Question: Identify the chart type used in this figure.
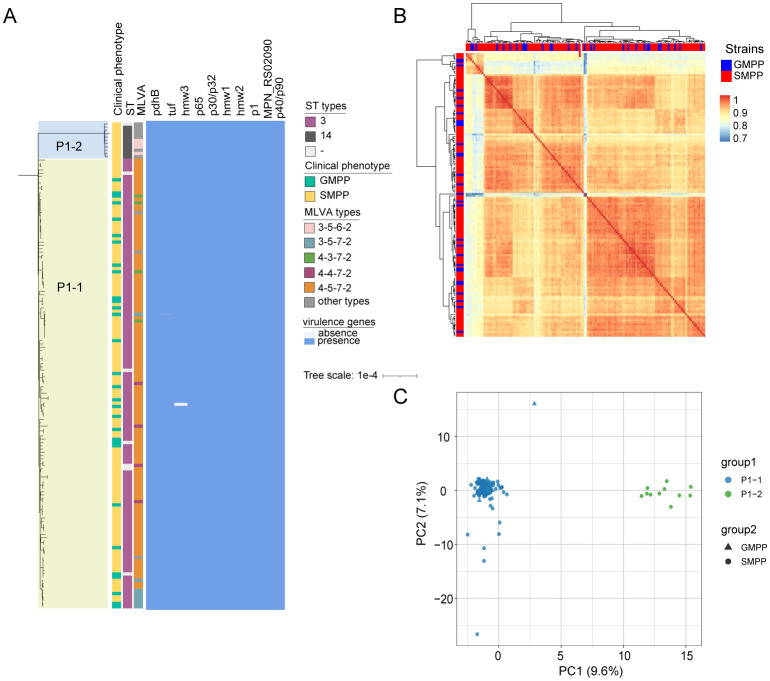
Answer: heatmap